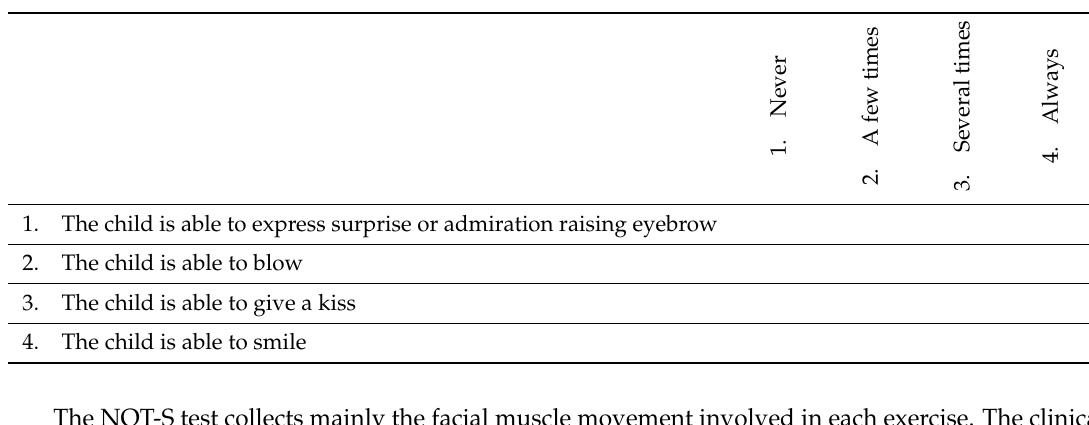
Table 3. Scale of facial movements evaluation of children with Cerebral Palsy.